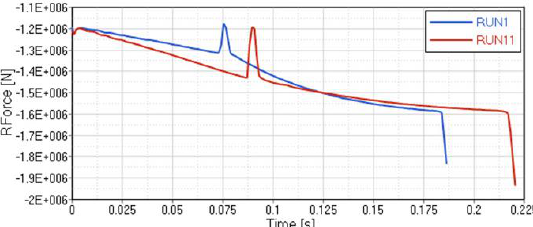
Figure 14. Punch displacement with stepwise, in correspondence of S and T1. TT represents the last point of the curve with maximum value in the x axis; blank0.